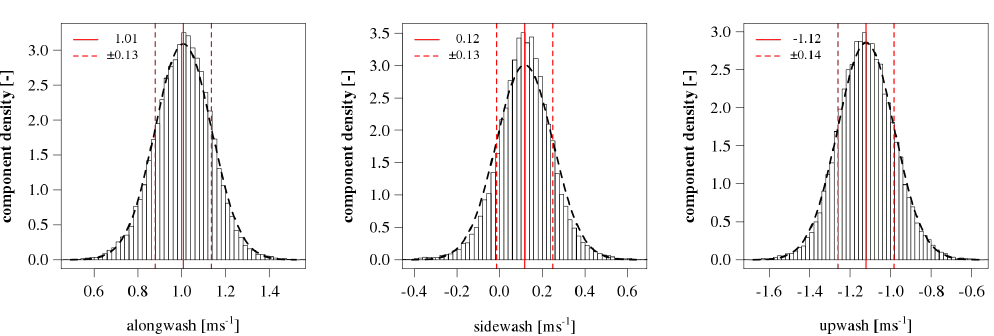
Fig. 5. Histograms of wing-generated alongwash, sidewash and upwash at the five hole probe location. Results are calculated from wing properties in Eqs. (1)–(3) and then rotated from wing- into trike body coordinates (Fig. 2) using Eq. (A13). Presented is the same dataset and in the same manner as in Fig. 4.